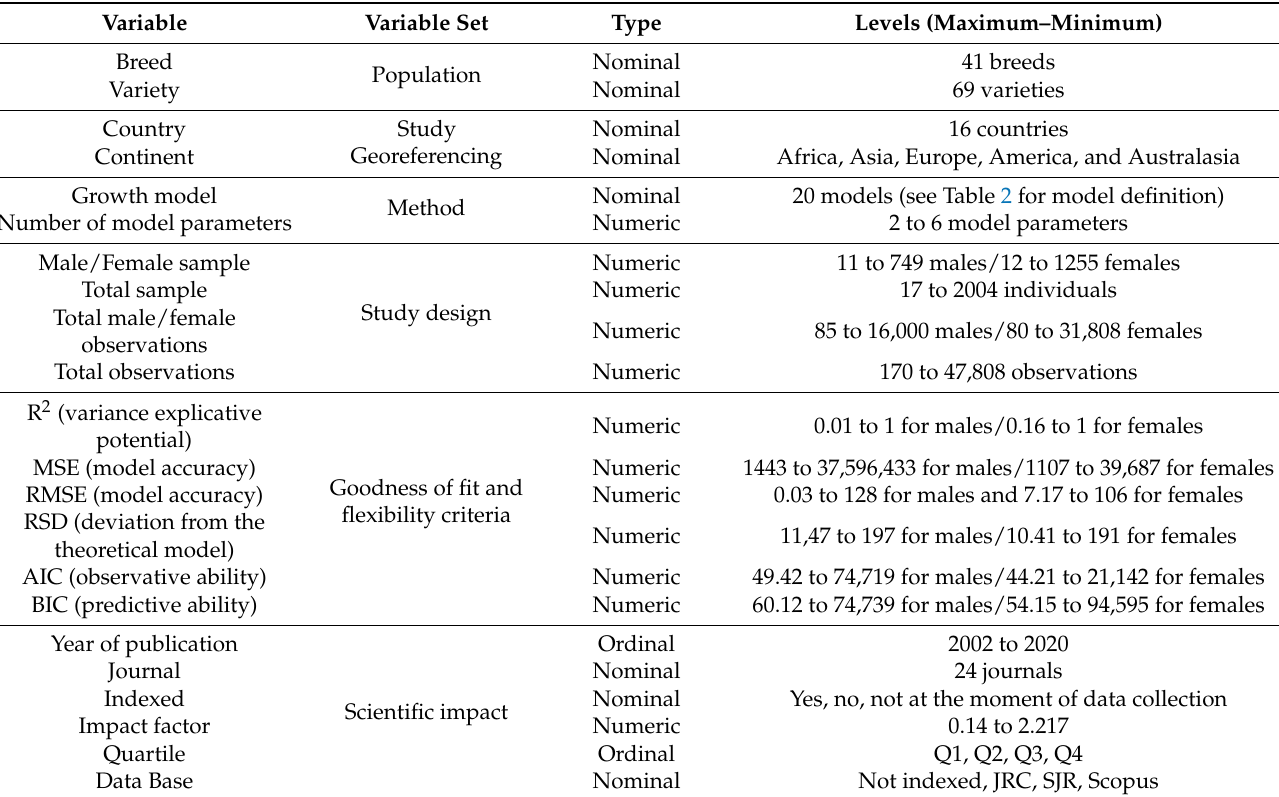
Table 1. Nature, maximum, minimum (numeric and ordinal variables), and levels (nominal and ordinal variables) of the variables considered in the